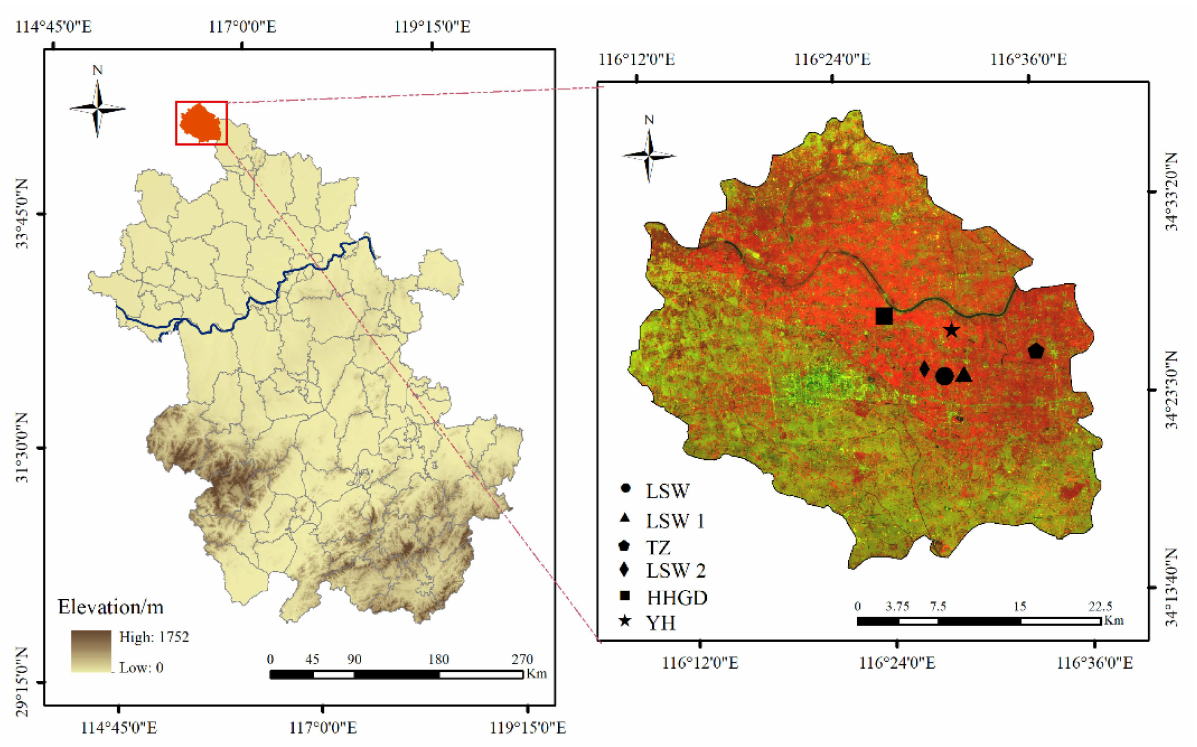
Figure 1. Geographic origins of pear samples used in this